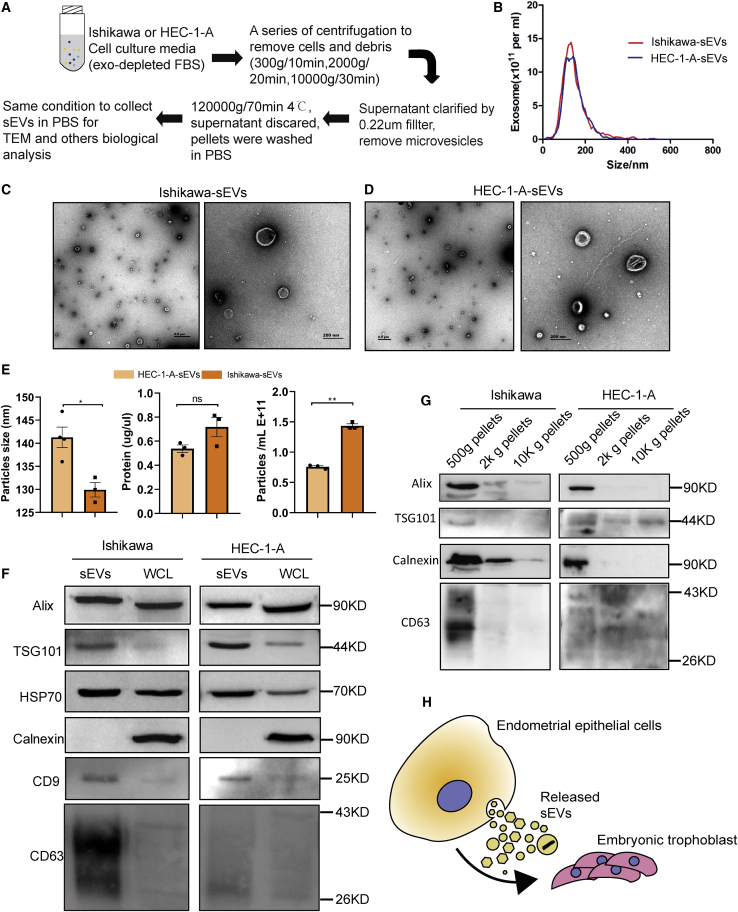
Characterization of sEVs derived from endometrium epithelial cells(A) Procedure for isolating sEVs from Ishikawa and HEC-1-A cell culture supernatant using ultracentrifugation. (B) NTA (concentration and size distribution) of Ishikawa-sEVs and HEC-1-A-sEVs. (C and D) Ishikawa-sEVs (C) and HEC-1-A-sEVs (D) were negatively stained, and representative transmission electron microscopy (TEM) images were shown, respectively. (E) Mean particle size of sEVs, protein concentration per milliliter, and particle number per milliliter. (F) Western blot analysis of WCL and exosomal protein markers Alix, TSG101, HSP70, CD9 and CD63, and calnexin as a negative control. (G) The pellets precipitated in each step of differential centrifugation were blotted for exosomal marker CD63, Alix, TSG101, and endoplasmic reticulum marker calnexin. (H) Schematic of in vitro functional assay of endometrial cell sEVs. sEVs derived from endometrial epithelial cells carry cargos and deliver to embryonic trophoblast cells (∗p < 0.05; ∗∗p < 0.01; ∗∗∗p < 0.001).